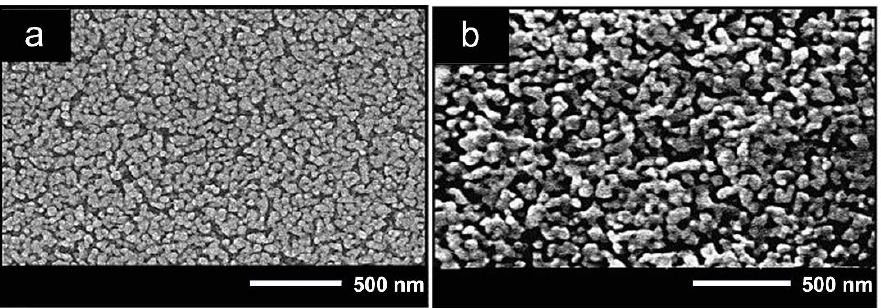
Figure 1. SEM images of undoped ZnO ( a ) and Mn-doped ZnO ( b ) nanostructures. Modified from reference [65]. Reference